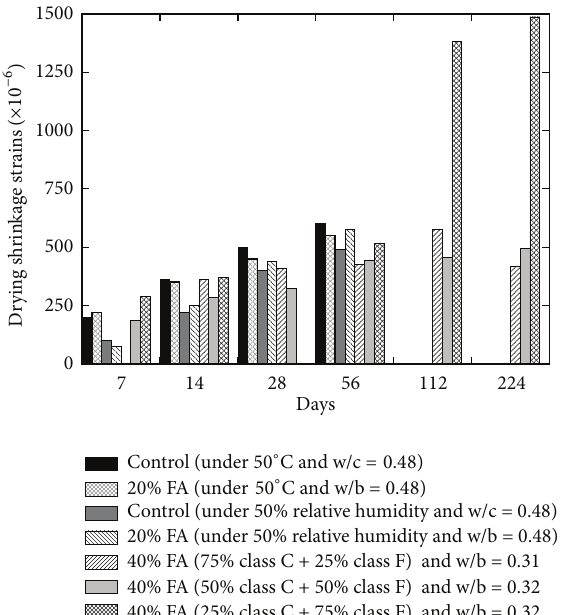
Figure 3: Effect of plain and blended GGBS on the drying shrinkage of GGBS concrete [9].